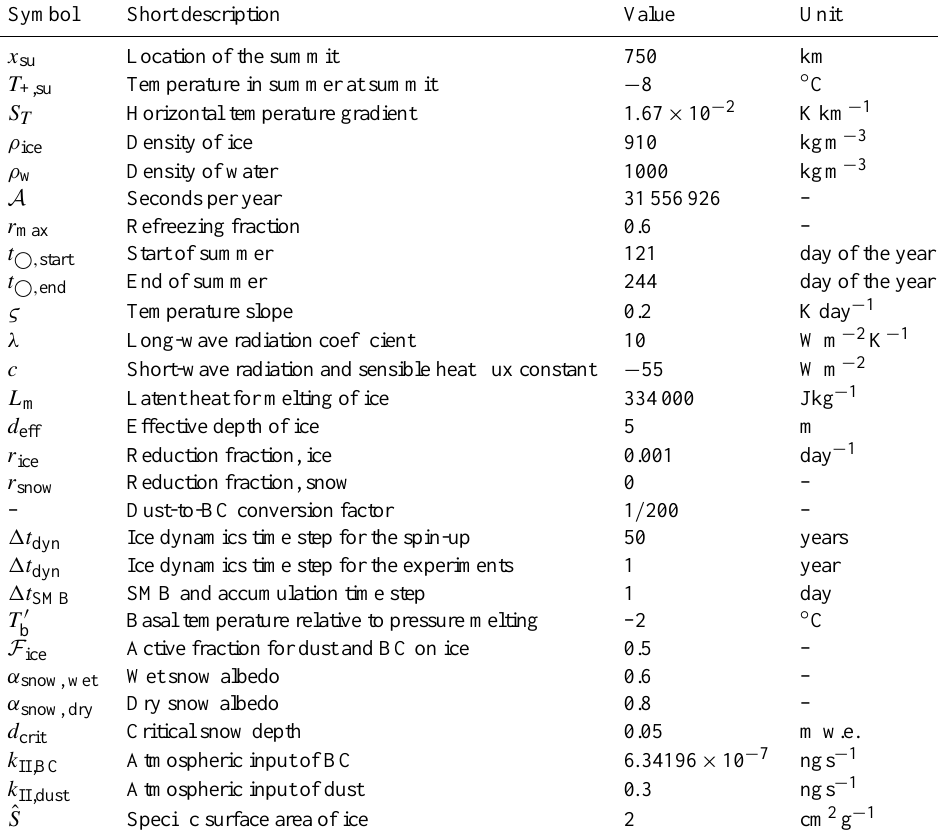
Table 1. Standard physical parameters and constants. Symbol Short